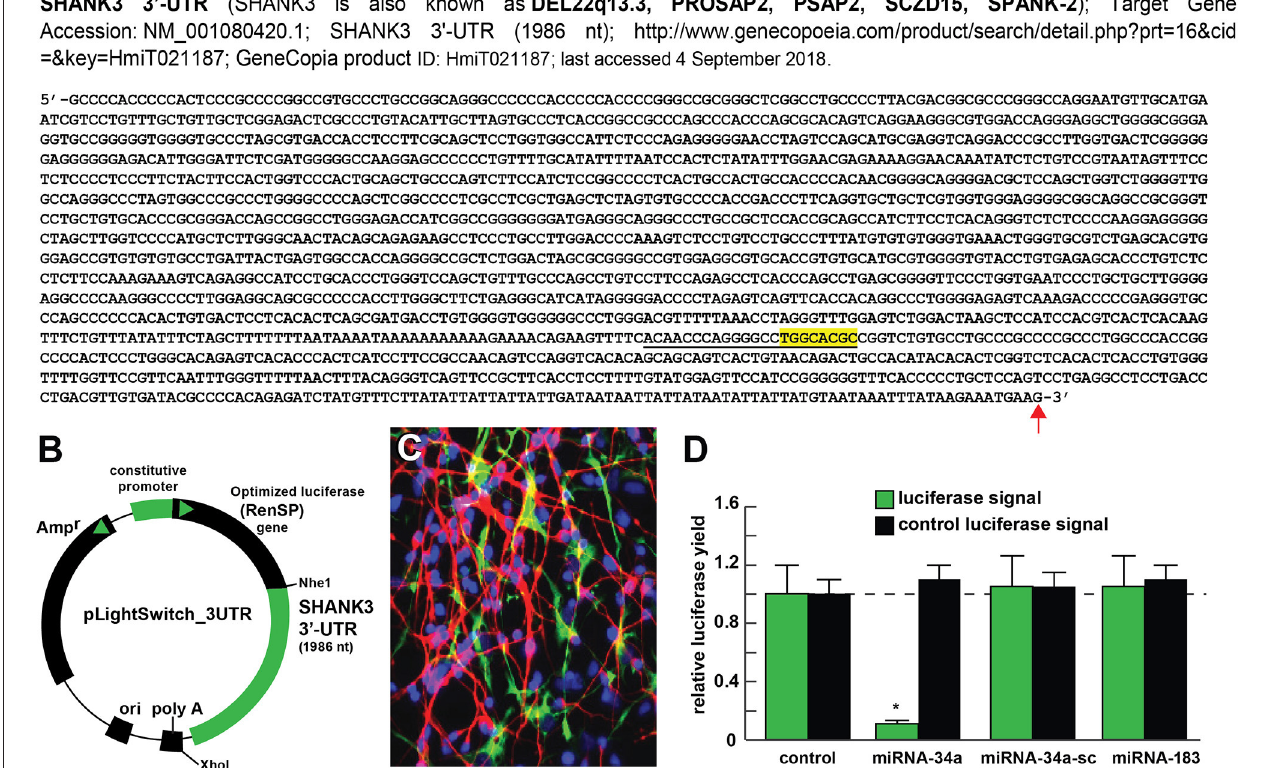
FIGURE 2 | Luciferase reporter vector-based studies of miRNA-34a and SHANK3 expression - Functional validation of a miRNA-34a-SHANK3–3 ′ UTR interaction. (A) partial ribonucleotide sequence of the 1986 nt SHANK3-mRNA-3 ′ -UTR is shown in the 5 ′ -3 ′ direction; the 22 nucleotide (nt) miRNA-34a-SHANK3-3 ′ UTR complementarity-interaction region is indicated by a black underline and the 8 nt SHANK3-mRNA-3 ′ -UTR seed sequence is overlaid in yellow; a single vertical red arrow indicates the 5 ′ end of a poly A + tail in the SHANK3 mRNA; the SHANK3 mRNA sequence derived from NM_018965; (B) SHANK3-mRNA-3 ′ UTR expression vector luciferase reporter assay (pLightSwitch-3 ′ UTR; Cat#S801178; Switchgear Genomics, Palo Alto CA); in this vector, the entire 1986 nucleotide SHANK3 3 ′ UTR was ligated into the unique Nhe1-Xho1site; not drawn to scale; (C) HNG cells, 2 weeks in primary culture; neurons (red stain; λ max = 690nm), DAPI (blue nuclear stain; λ max = 470nm) and glial fibrillary associated protein (GFAP; glial-specific green stain; λ max = 520nm); the HNG cell culture is about 60% confluent and at 2 weeks of culture contains 70% neurons and 30% astroglia; human neurons do not culture well in the absence of glia; neurons also show both extensive arborization and display electrical activity (unpublished; Lonza); 40X magnification; HNG cells were transfected with the SHANK3-mRNA-3 ′ UTR expression vector luciferase reporter were treated exogenously with a stabilized miRNA-34a, a scrambled control miRNA-34a (miRNA-34a-sc) or control miRNA-183; see references and text for further details; (D) compared to control, HNG cells transfected with a scrambled (sc) control pLightSwitch-3’UTR vector, the SHANK3-mRNA-3 ′ UTR vector exhibited decreased luciferase signal to a mean of 0.16-fold of controls in the presence of miRNA-34a; this same vector exhibited no change in the presence of the control